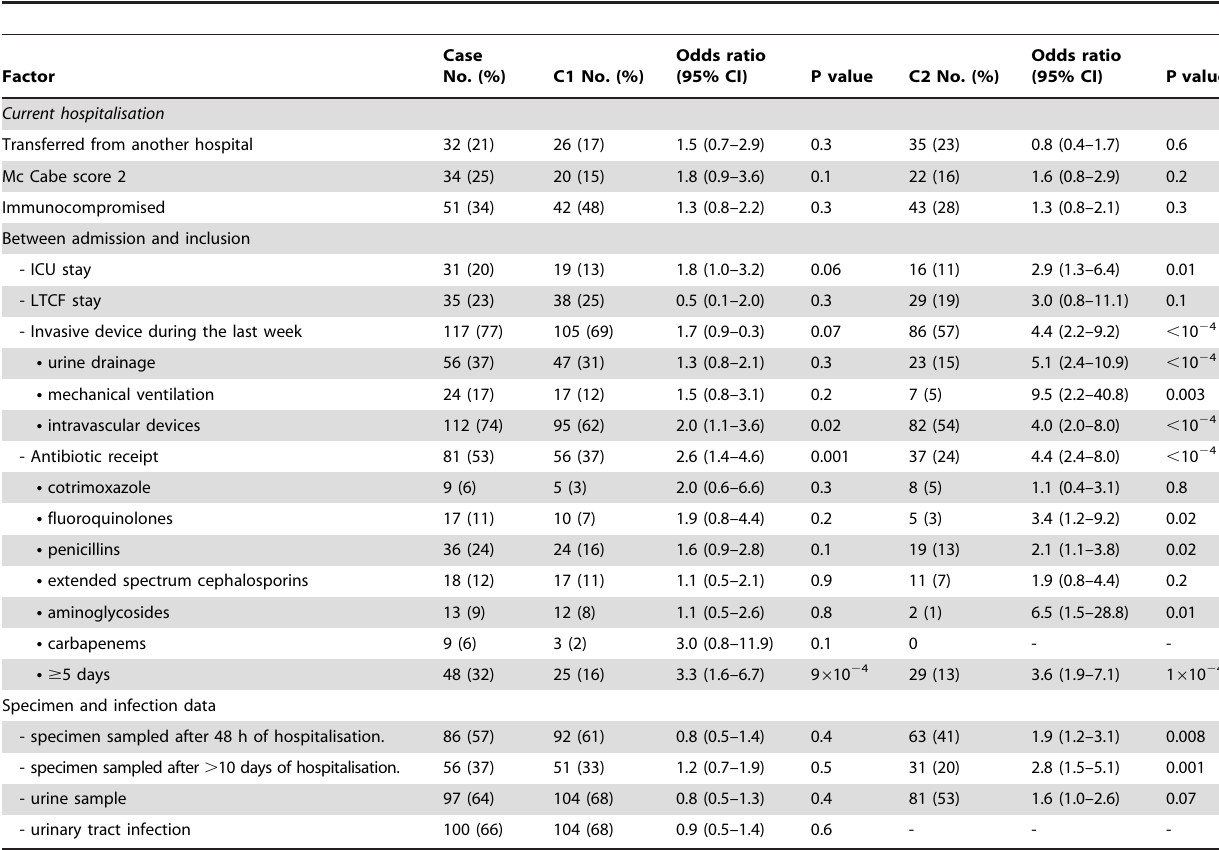
Table 3. Univariate analysis of current hospitalisation-related factors associated with a CTX-M-producing E. coli clinical isolate through a case (patient with a CTX-M producing E. coli isolate) - control (C1: patient with a non-ESBL-producing E. coli isolate) - control (C2: patient with negative clinical samples)